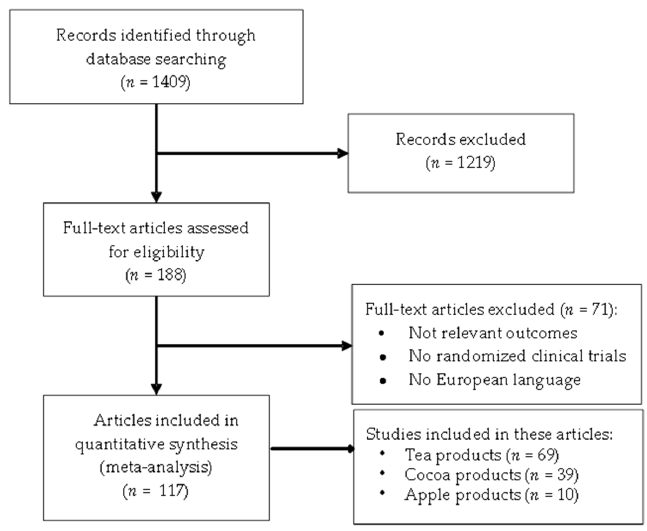
Figure 1. Flow diagram showing the study selection process.